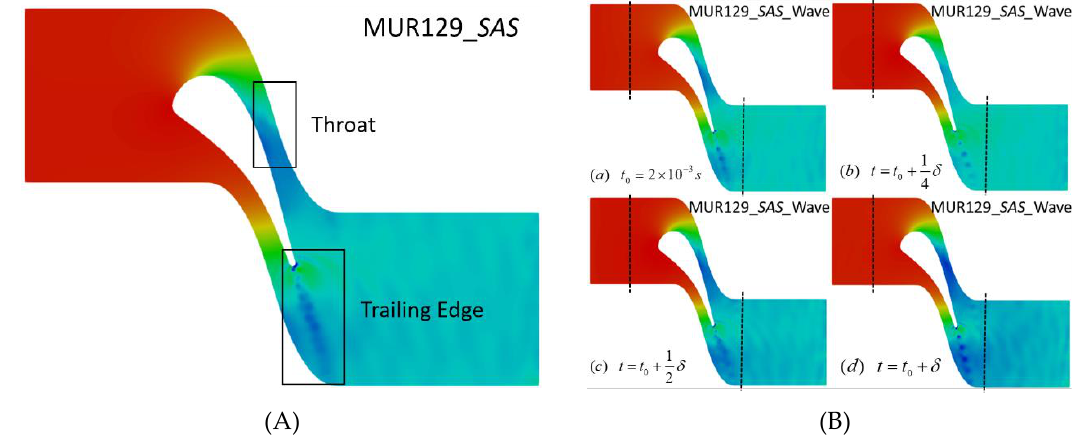
Figure 12. ( A ): Distribution of instantaneous static pressure (without entropy wave); ( B ): Distribution of Figure 12. (A): Distribution of instantaneous static pressure (without entropy wave); (B): Distribution instantaneousstaticpressureatdi ff erenttimeswithinoneperiodwithentropy( δ = 2 π / ω 0 = 1 ms of instantaneous static pressure at different times within one period with entropy ( ) wave.